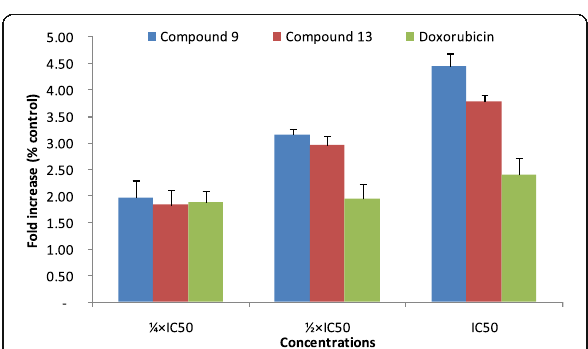
Fig. 5 Production of ROS in MCF-7 cells treated with thonningiol (9), seputhecarpan D (13) for 24 h. IC 50 : 0.36 μ M (thonningiol), 9.78 μ M (seputhecarpan D) and 0.35 μ M (doxorubicin)